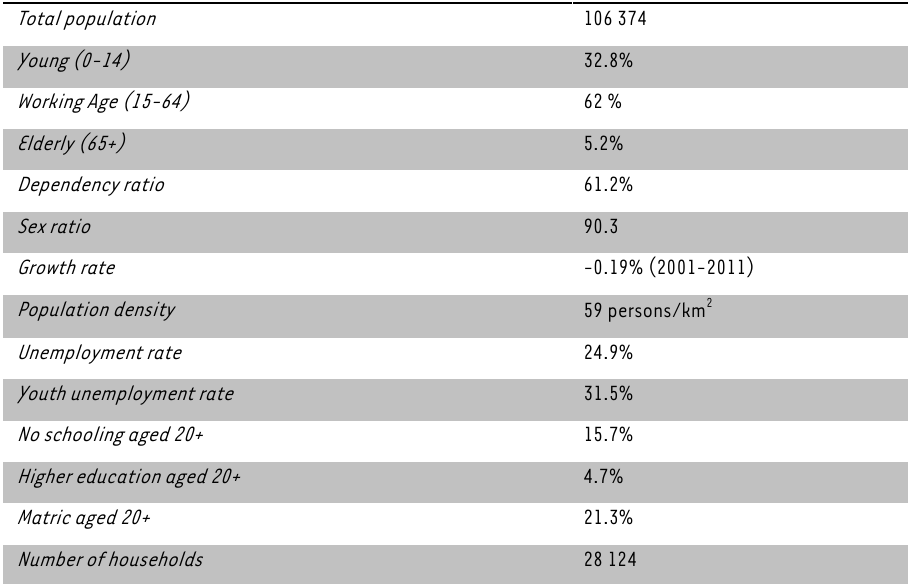
Key statistics for uMshwathi, Census